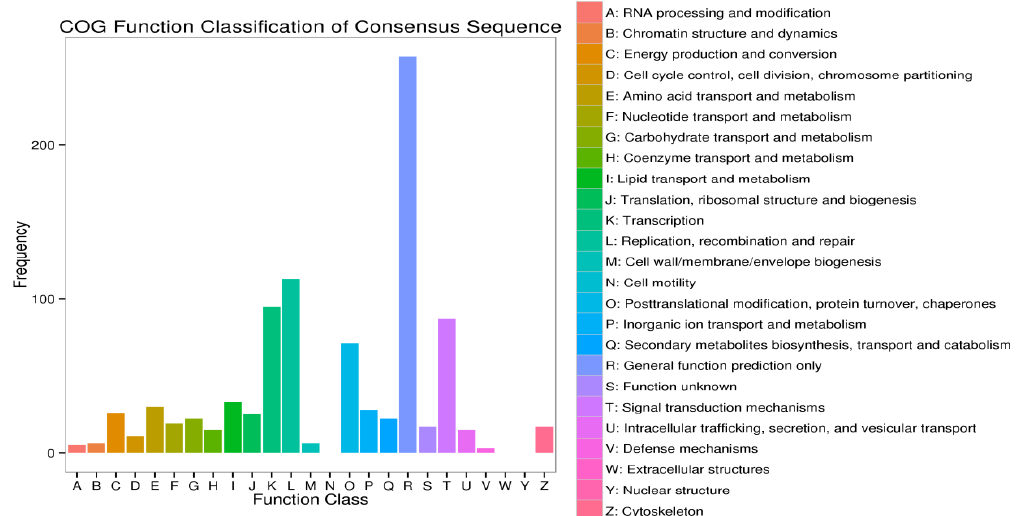
Figure 6. Orthologous classification of the differentially expressed genes in the COG (Clusters of Orthologous Groups) database between the experimental group and the control group. The abscissa is the COG (Clusters of Orthologous Groups) content of each classification, and the ordinate is the number of genes. In different functional categories, the number of genes reflects the corresponding period and the environment under the metabolic or physiological biases and other content, and the object can be combined with the distribution of various functional classes to generate a scientific explanation.